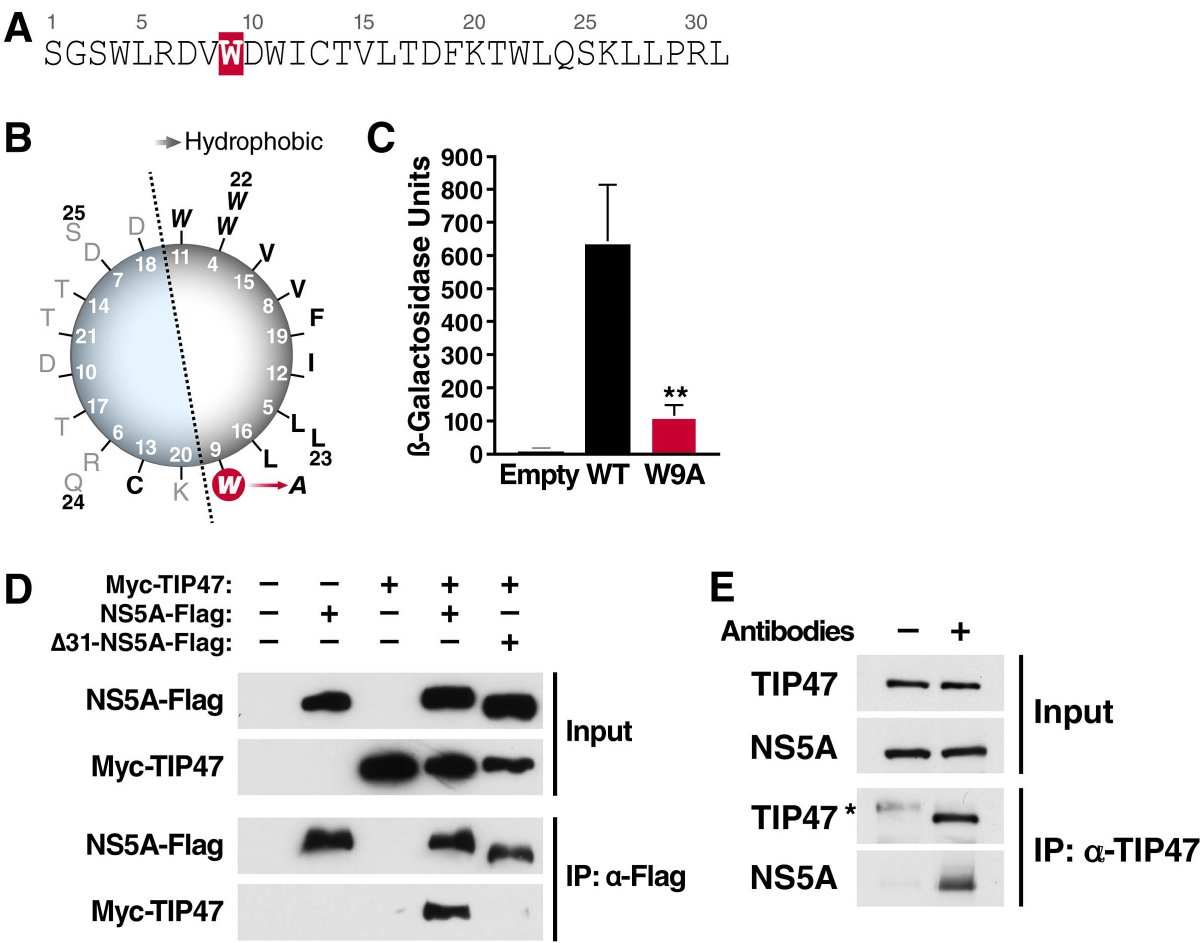
Figure 1. Yeast-two-hybrid screen identified TIP47 as a novel binding partner of NS5A. A) Sequence of the N-terminal 31 amino acids of NS5A (genotype 1b) that was used as bait in the screen. B) Wheel diagram of the N-terminal amphipathic a -helix of NS5A (amino acids 4–25). The position of the tryptophan-to-alanine mutation at position 9 (W9A) is highlighted in red. C) Quantitative Y2H assay of either wild-type NS5A (amino acids 1–14) as bait and control prey (empty), wild-type NS5A (amino acids 1–14) as bait and TIP47 as prey (WT), or NS5A containing W9A mutation (amino acids 1–4) as bait and TIP47 as prey (W9A). Values shown are means of b -galactosidase reporter gene activity 6 standard deviation; n=6, **P , 0.01. D) Coimmunoprecipitation assays in Huh7 cells transfected with expression vectors for Myc-TIP47 and NS5A-Flag or D 31-NS5A-Flag proteins. After immunoprecipitation with antibodies specific for Flag, TIP47 was detected by western blotting with antibodies specific for Myc. E) Coimmunoprecipitation assays in replicon Cells (Con1, genotype 1b, Figure 2A). After immunoprecipitation with antibodies specific for Flag (antibodies -) or TIP47 (antibodies + ), TIP47 and NS5A were detected by western blotting with antibodies specific for TIP47 or NS5A, respectively. * unspecific